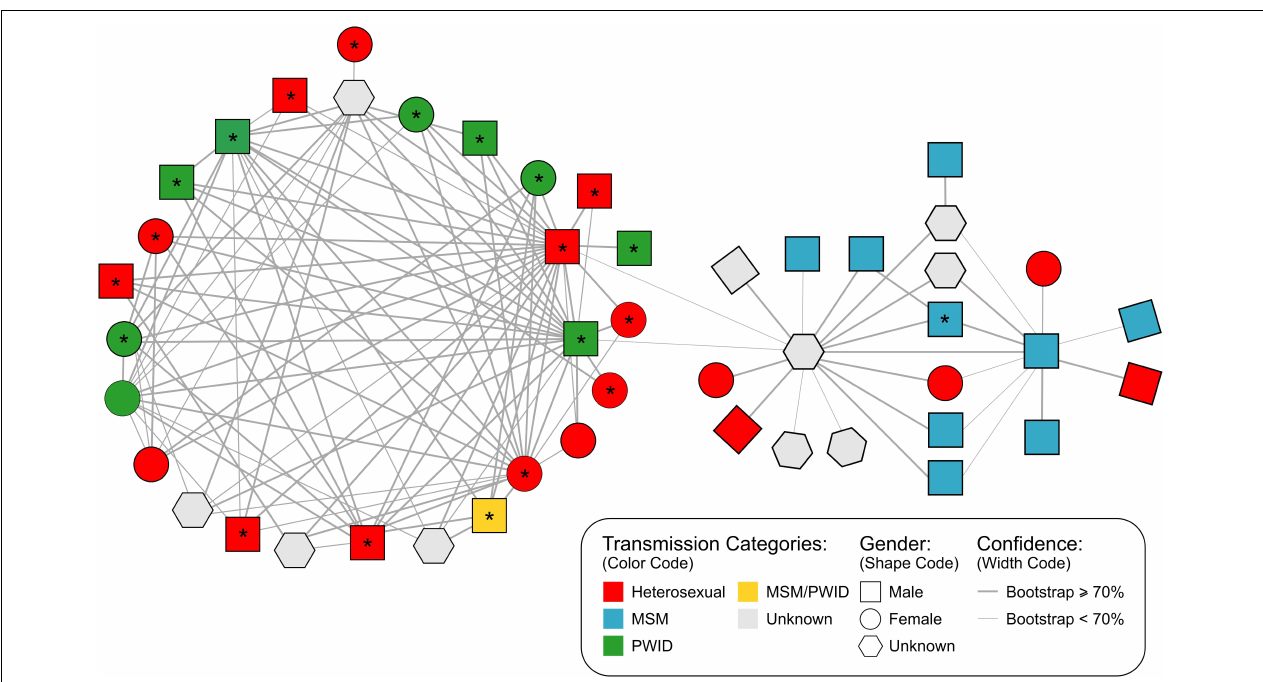
FIGURE 2 | Inferred genetic network structure of a major cluster (N = 47 individuals) in the San Mateo HIV-1 subtype B epidemic identified by HIV-TRACE using a genetic distance threshold of 2%. Shape codes gender, colors denote the reported mode of transmission for each individual and line width represents the bootstrap confidence for linkage. ∗ are indicating African-American individuals. MSM, men who have sex with men; PWID, people who inject drugs, injection drug